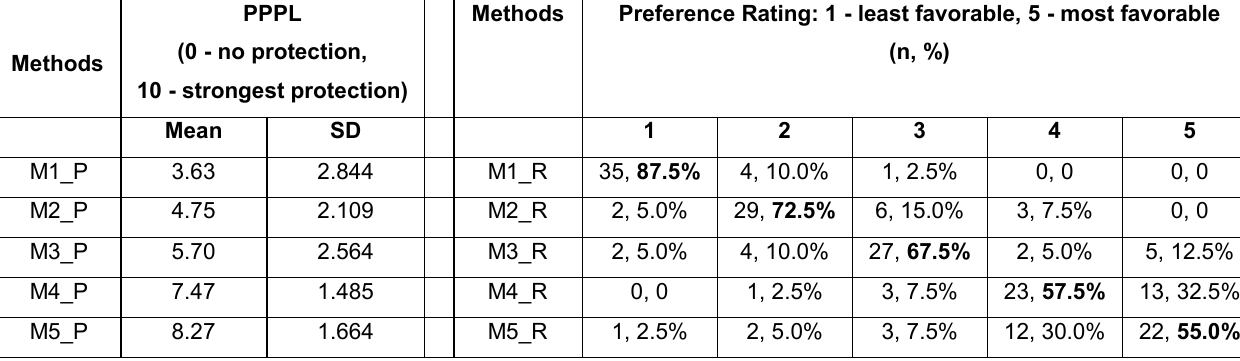
Perceived Privacy Protection Level and Preference Ratings for the Five Privacy Protection Methods